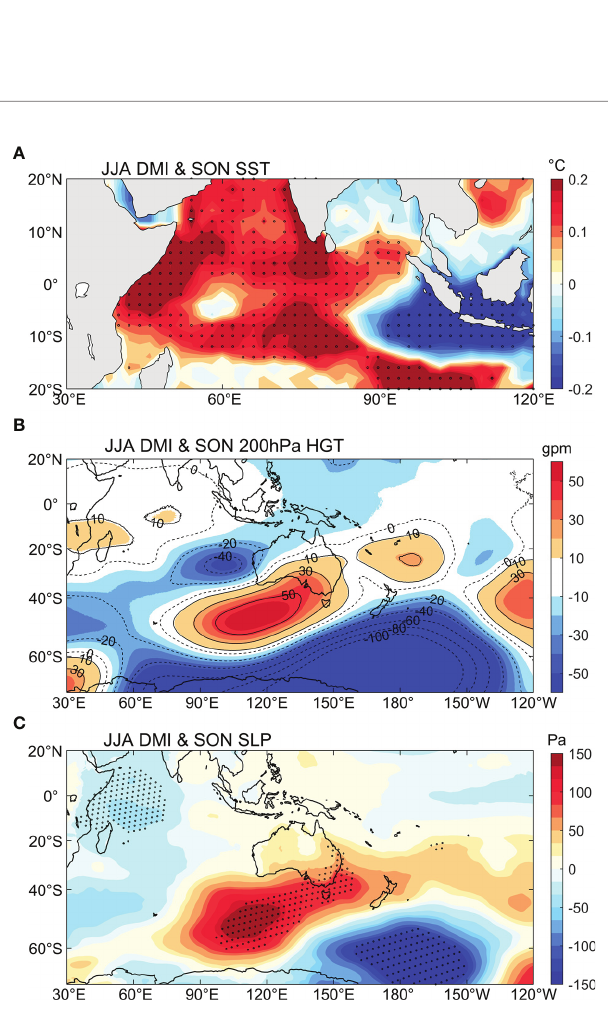
FIGURE 10 | Regression coef fi cients of SON-averaged (A) SST anomalies, (B) 200 hPa geopotential height anomalies and (C) SLP anomalies on the normalized JJA-averaged DMI. SST and SLP anomalies which are signi fi cant at the 95% signi fi cance level are